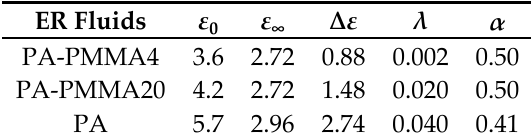
Figure 16. Loss factor for ER fluids based on PANI (PA) and PMMA/PANI with PANI shell thickness of 11 (PA-PMMA4) and 52 nm (PA-PMMA20) as a function of the dielectric constant. The solid lines were drawn using Equation (10). (Cho et al. [120], Copyright Springer Nature, 2002). Table 2. Parameters in Equation (10) in Figure 16. (Reprinted from [120], Copyright Springer Nature, 2002). Polymers 2018 , 10 , x FOR PEER REVIEW 24 of 31